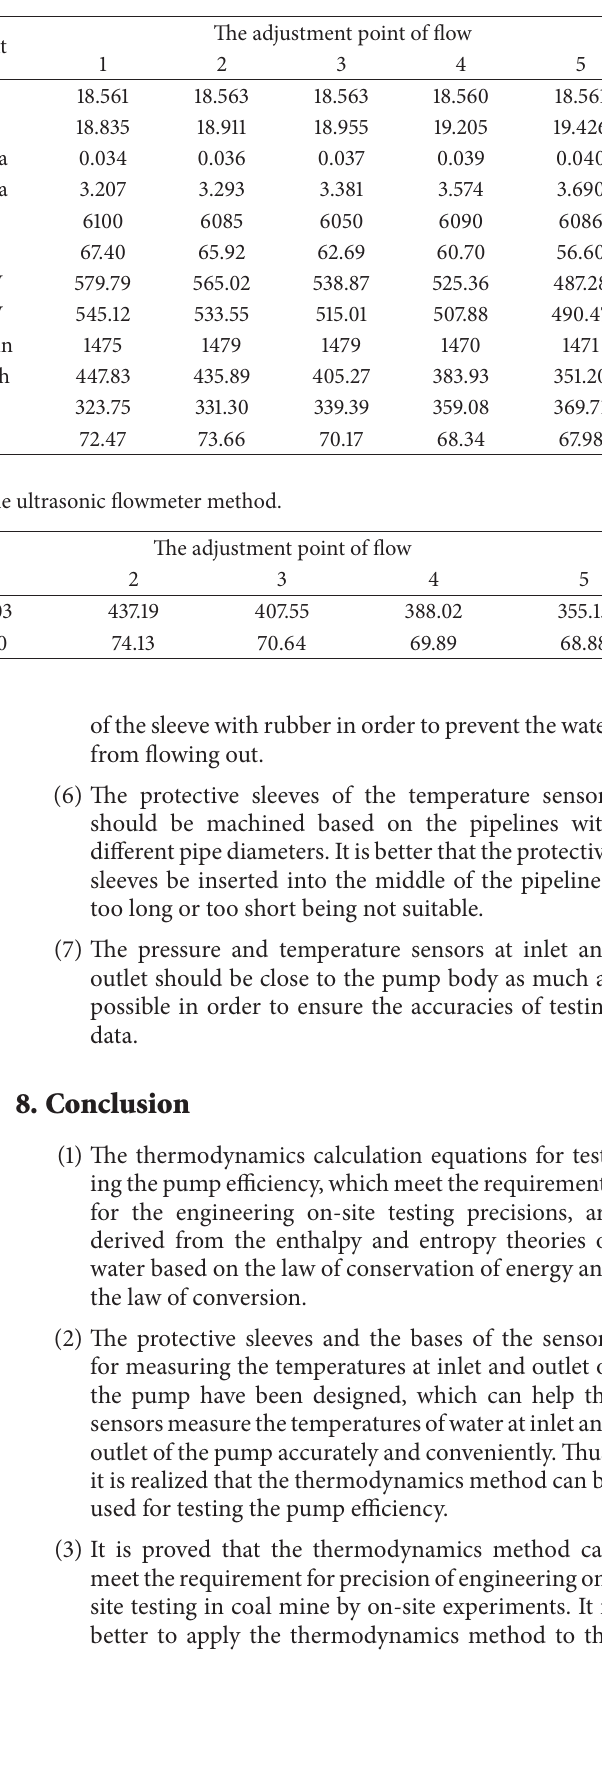
Table 1: The test data through the thermodynamic method.